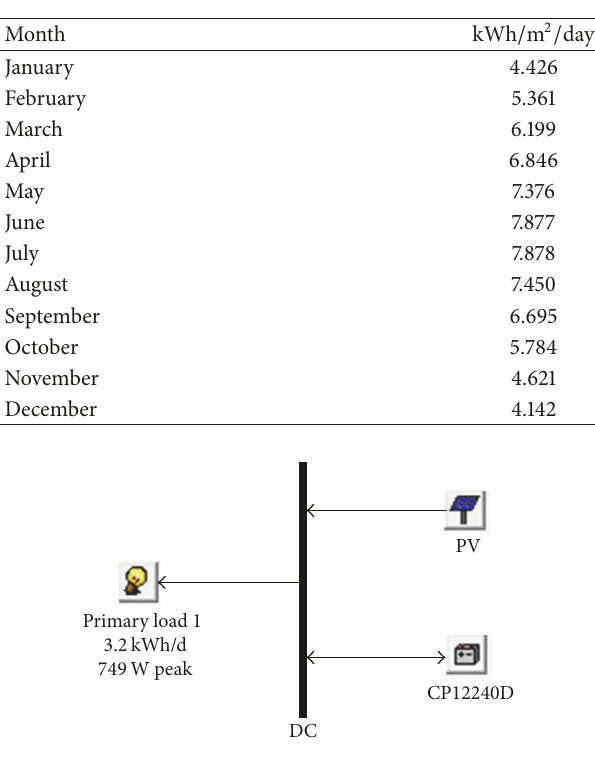
Figure 2: System implementation in